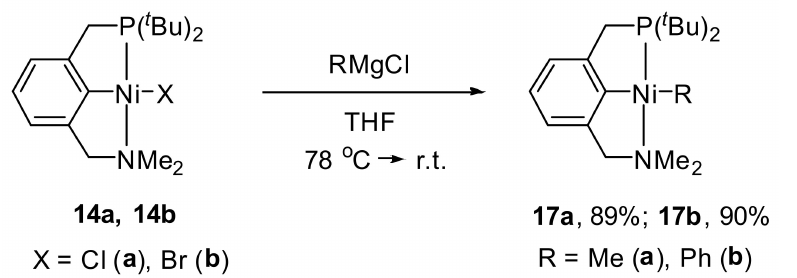
Scheme 6. Synthesis of unsymmetrical PCN pincer alkyl and aryl-nickel complexes 17a and 17b [96]. Later, Moussa and co-authors presented the synthesis of an unsymmetrical PCN pincer complex of nickel bearing tertbutyl groups on the phosphorus atom and isopropyl groups on the nitrogen donor atom (complex 18 in Scheme 7) [98]. The corresponding methyl complex 19 was also obtained from 18 through a transmetalation reaction with MeMgCl. Complex 19 demonstrated a high reactivity in a carboxylation of a Ni − C bond using CO 2 with the formation of acetate complex 20 .